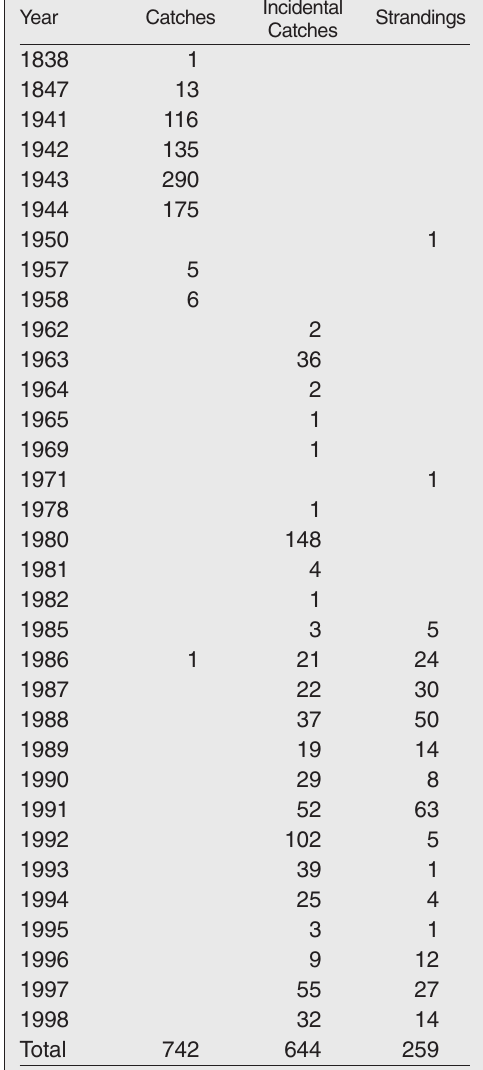
Table 10. Records of harbour porpoise in the database, from 1838 to 1998 inclusive, according to source where specified. There are animals listed in the database for which the source is not